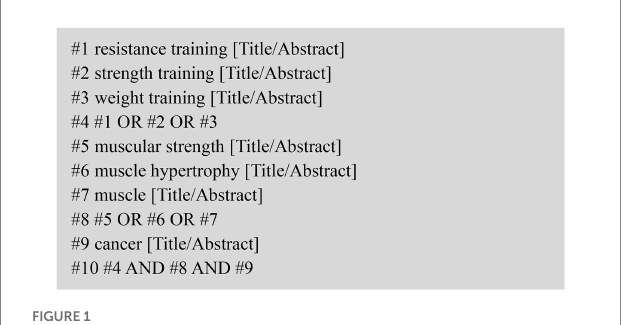
FIGURE 1 PubMed database search